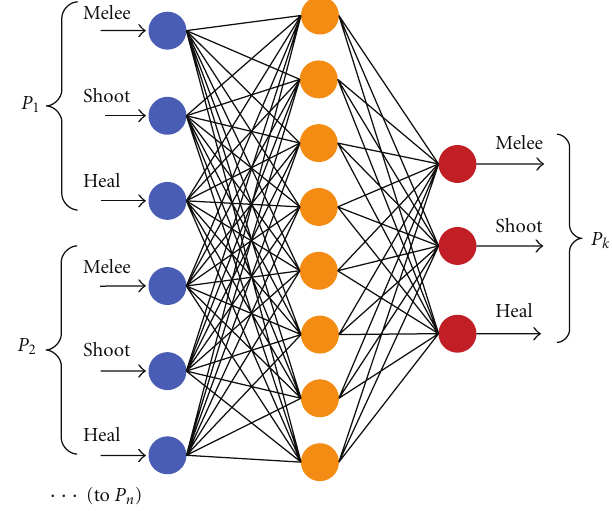
Figure 5: Experimental setup of the fundamental TAP model tests: the neural network implementation of the adapter. This diagram shows the neural network structure that is implemented for the experiments. The number of input neurons (blue-colored neurons) is equal to n t × n a , where n t is the number of input TAPs and n a the number of adaptable actions in each TAP. The number of output neurons (red-colored neurons) is hence n a . The number of hidden neurons (orange-colored neurons) is